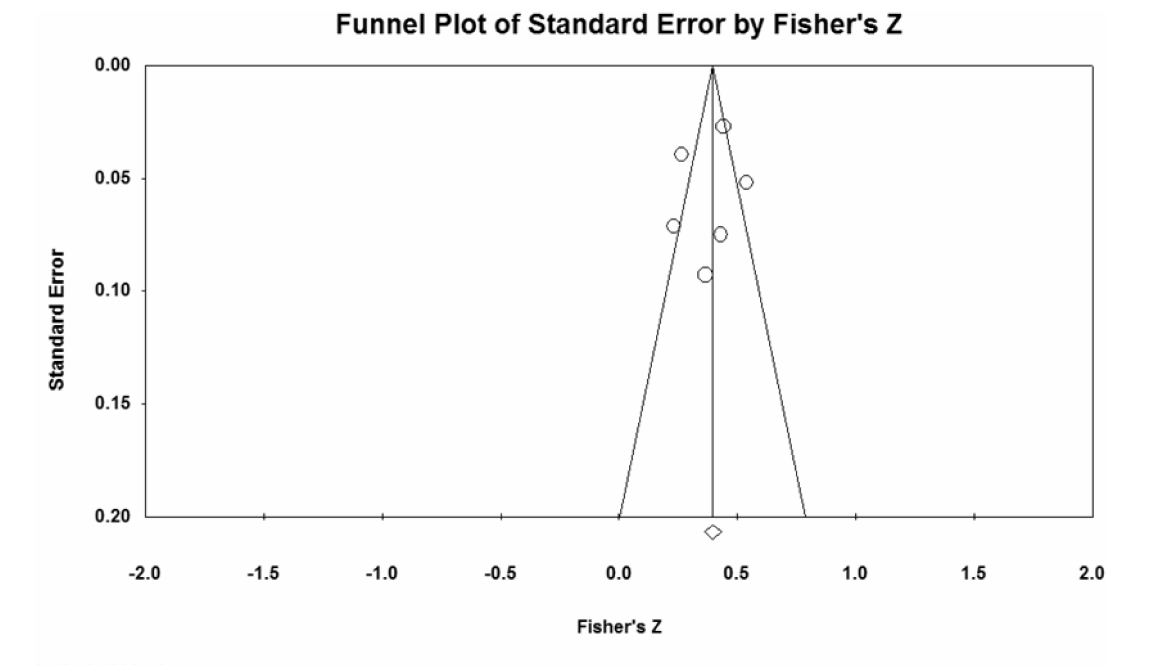
should consider parenting with high levels of support and responsiveness, and they should be wary of neglectful and inconsistent